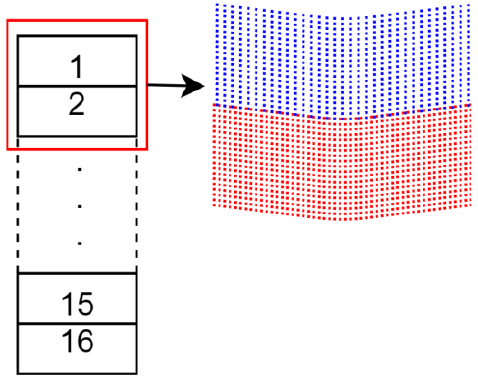
Figure 8. Point cloud blocks of laser beams on the front plane 1.